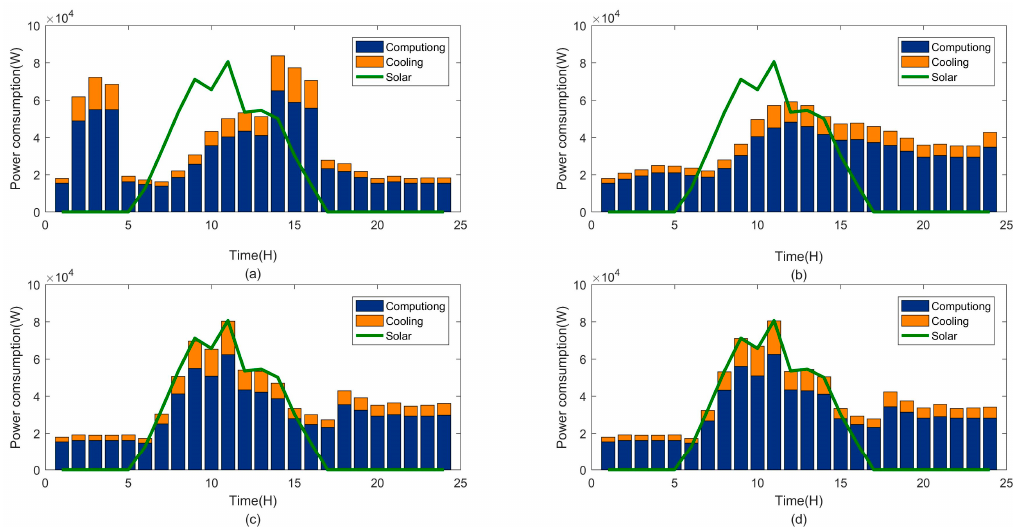
Figure 5. Detailed power consumption under four strategies (sunny): ( a ) ST ; ( b ) LB ; ( c ) BS ; ( d ) TM .